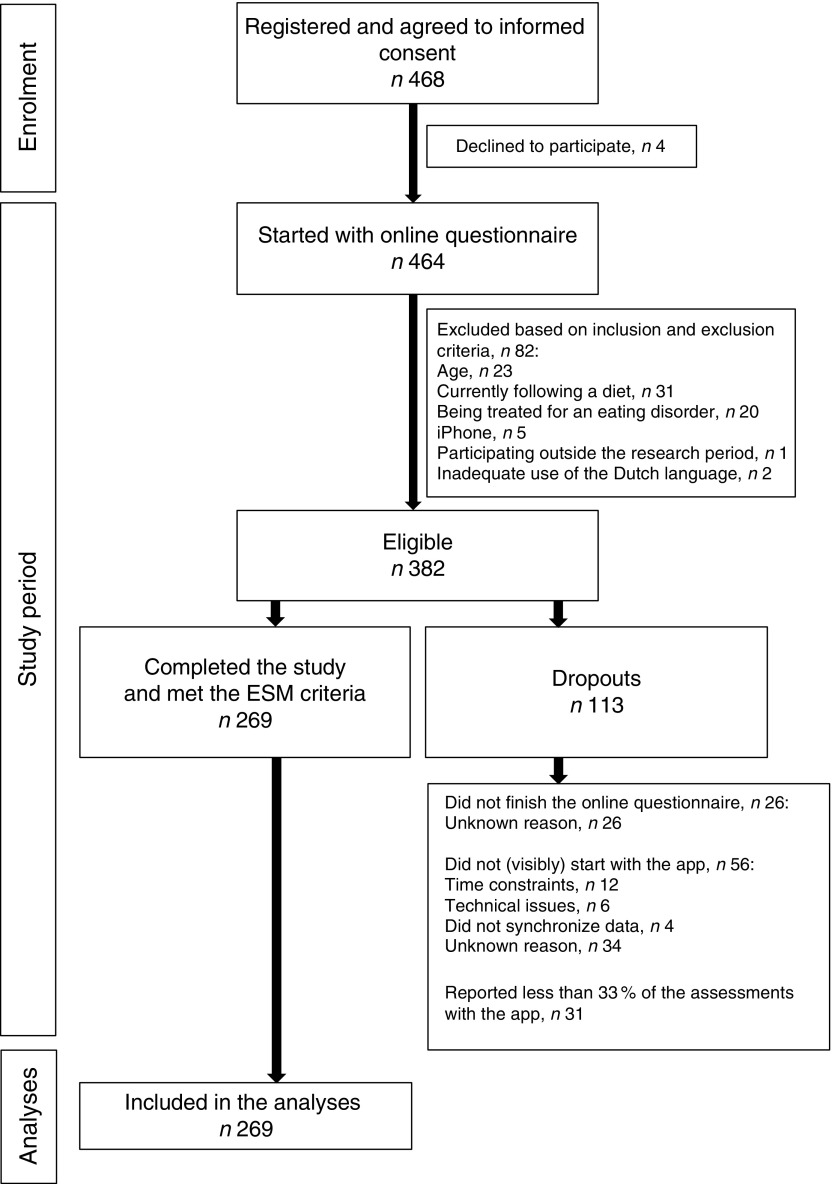
Study flowchart (ESM, experience sampling method)